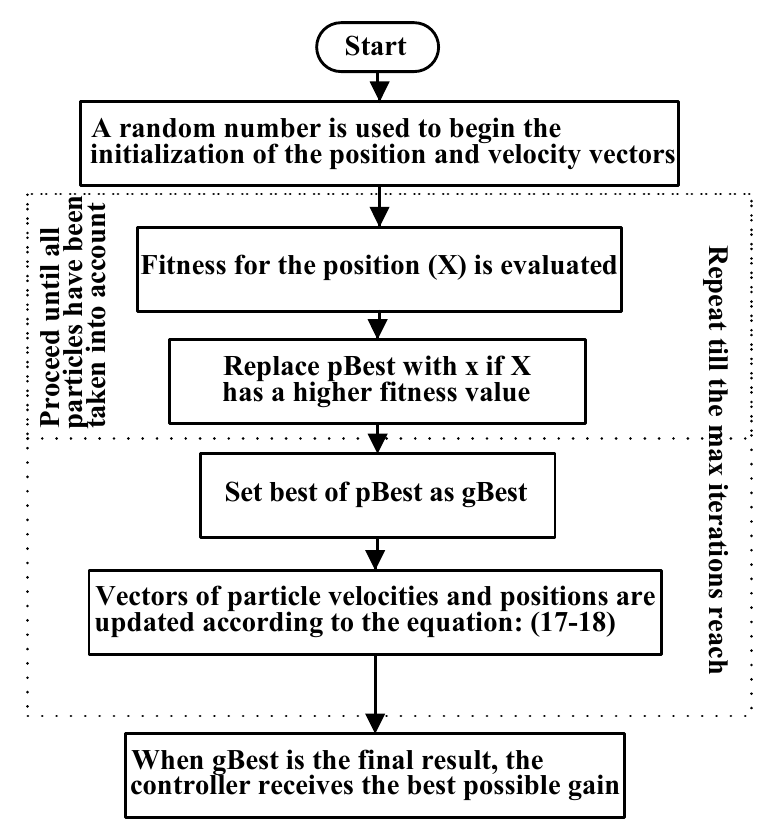
Figure 9. Flow chart of particle swarm optimization.